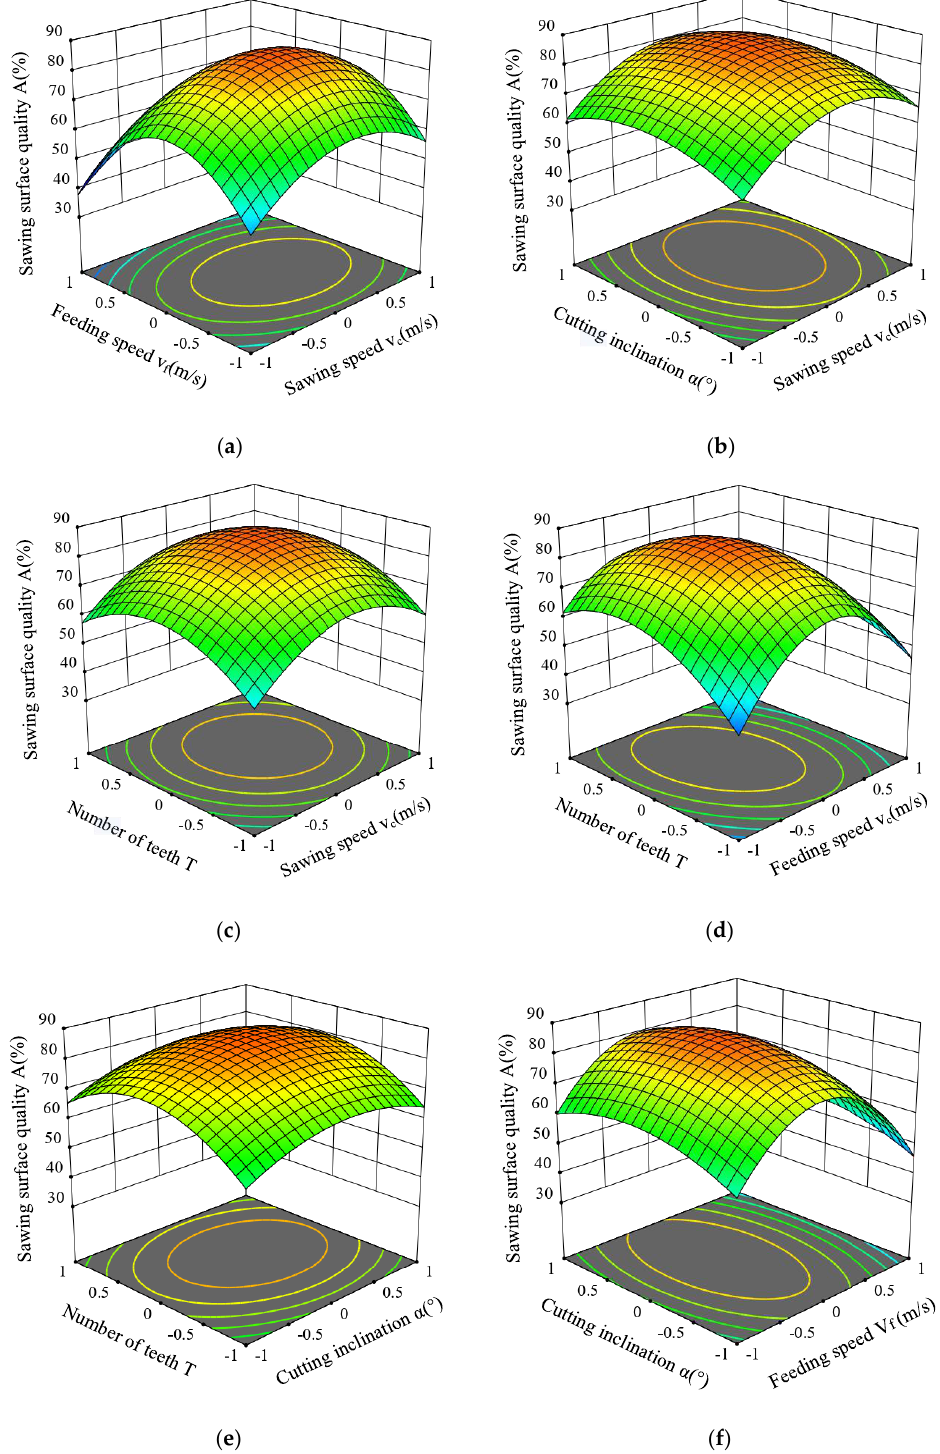
Figure 18. Influence of interaction factors on sawing surface quality. (( a ) A = f( 𝑣 𝑐 , 𝑣 𝑓 ,0,0); ( b ) A = f( 𝑣 𝑐 , 0 , α ,0); ( c ) A = f( 𝑣 𝑐 ,0,0, T ); ( d ) A= f(0, 𝑣 𝑓 ,0, T ); ( e ) A = f(0,0, α , T ); ( f ) A = f(0, 𝑣 𝑓 , α , T )).